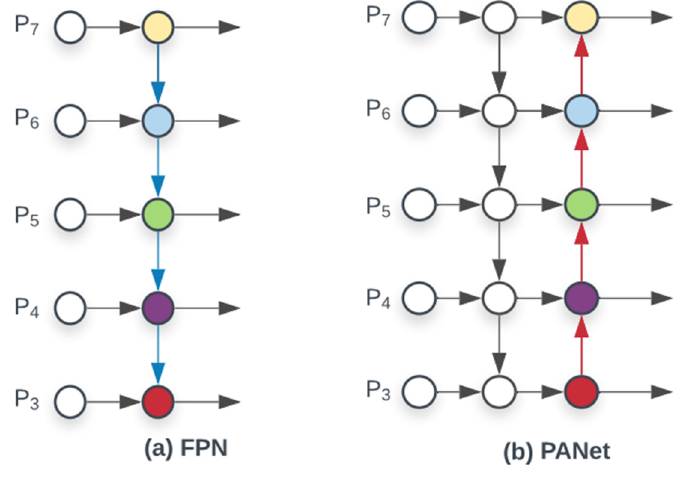
Figure 6. Feature pyramid network (FPN) ( a ) introduces a top-down pathway to fuse multi-scale features from level 3 to 7 (P3–P7); ( b ) PANet adds an additional bottom-up pathway on top of FPN [45].